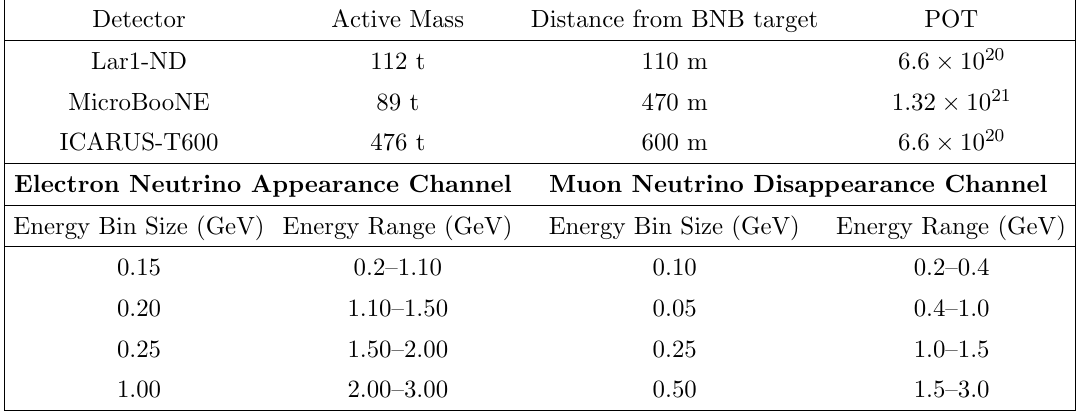
Table 1 . Upper: SBN detector active masses and distances from the local of the neutrino produc- tion. Lower: energy range and energy bin size of the electron and muon sample used in this analysis. ICARUS-T600 detectors and six years in MicroBooNE detector. It is important to empha- size that the detectors do not make a distinction between neutrinos and anti-neutrinos, so neutrino and anti-neutrino events are added in our simulations. After event reconstruction, we included an e(cid:14)ciency factor for each channel in order to mimic event rates from the SBN technical draft